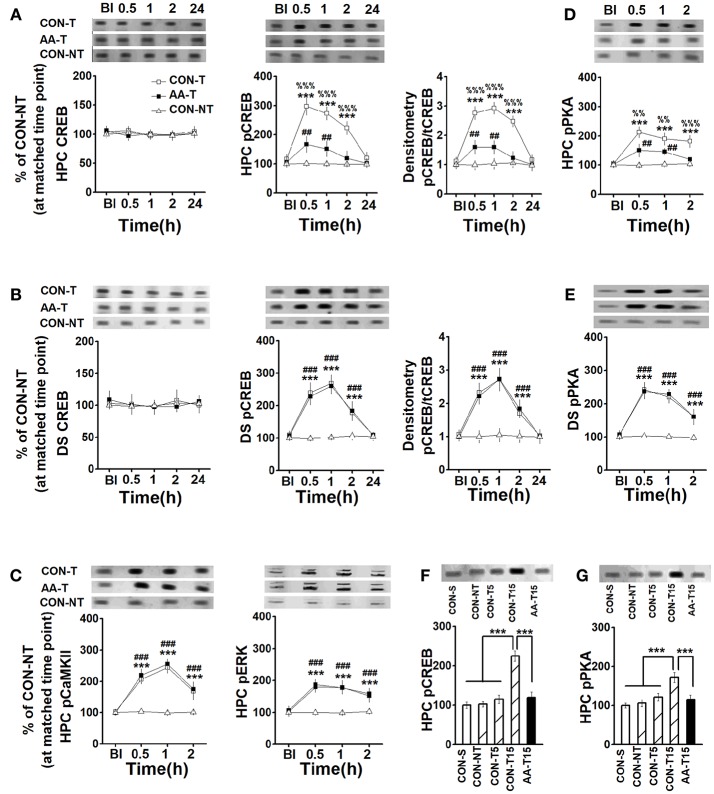
The expression of CREB, pCREB, pPKA, pCaMKII, and pERK in the HPC and DS following T-maze training. The expression of HPC CREB (left) and pCREB (middle), and the ratio of CREB to pCREB (right) (A), pCaMKII (left), and pERK (right) (C), pPKA (D) in rats that used place-strategy at different time points following training (Bl represented the time point of pre-learning). CON-T, AA-T, and CON-NT were represented the control training group, the AA training group and the control non-training group, respectively. n = 6 for each time point of each group. The expression of DS CREB (left) and pCREB (middle), and the ratio of CREB to pCREB (B), and pPKA (E) in rats that used response-strategy at different time points following training. CON-T, AA-T, and CON-NT were represented the control training group, the AA training group and the control non-training group, respectively. n = 8 for each time point of each group. (***P < 0.001, CON-T vs. CON-NT; ##P < 0.01, ###P < 0.001, AA-T vs. CON-NT; %%P < 0.01, %%%P < 0.001, CON-T vs. AA-T). The expression of HPC pCREB (F) and pPKA (G) in rats that used place-strategy after different learning trials. Representative Western blots were shown in all above insets. CON-S, CON-NT, CON-T5, CON-T15, and AA-T15 were the represented saline home cage control group, the control non-training group, the control 5-trial training group, the control 15-trial training group and the AA 15-trial training group, respectively. (***P < 0.001). n = 5 for each group.